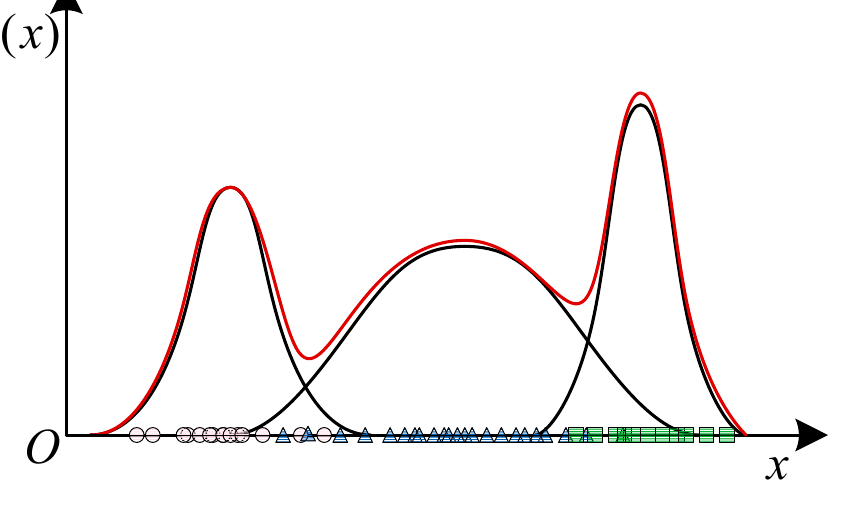
Figure 12. GMM classification.